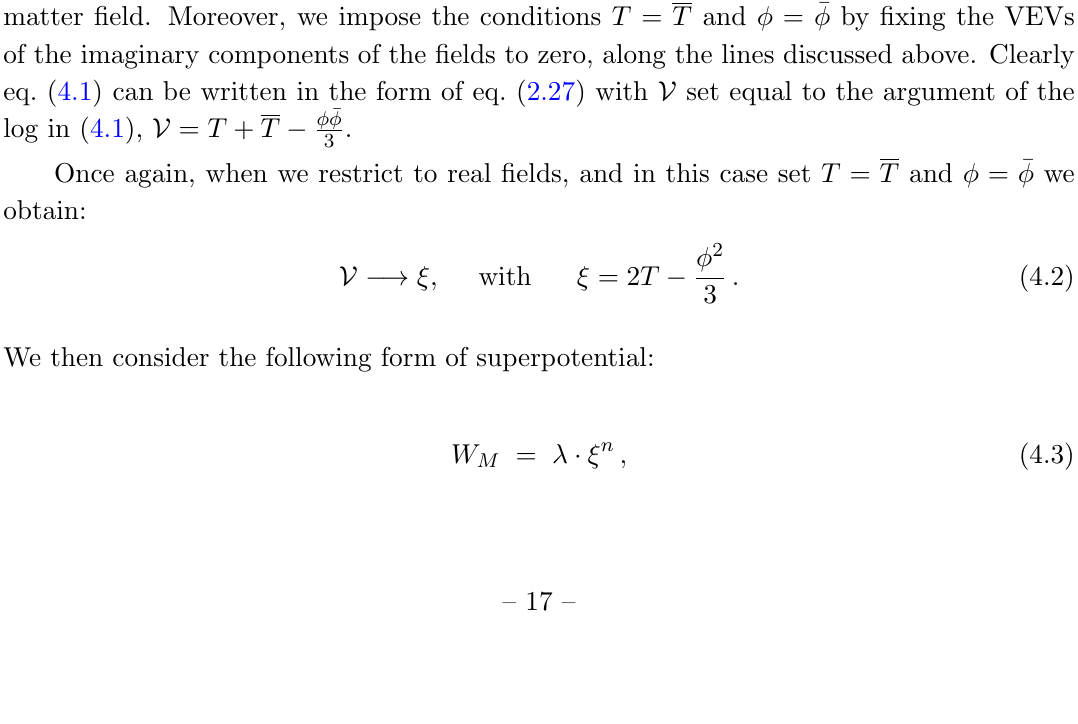
, 3 , 9 with 1 , 1 1 , 1 2 4 2 4 (cid:1) (cid:0) (cid:1) (cid:0)